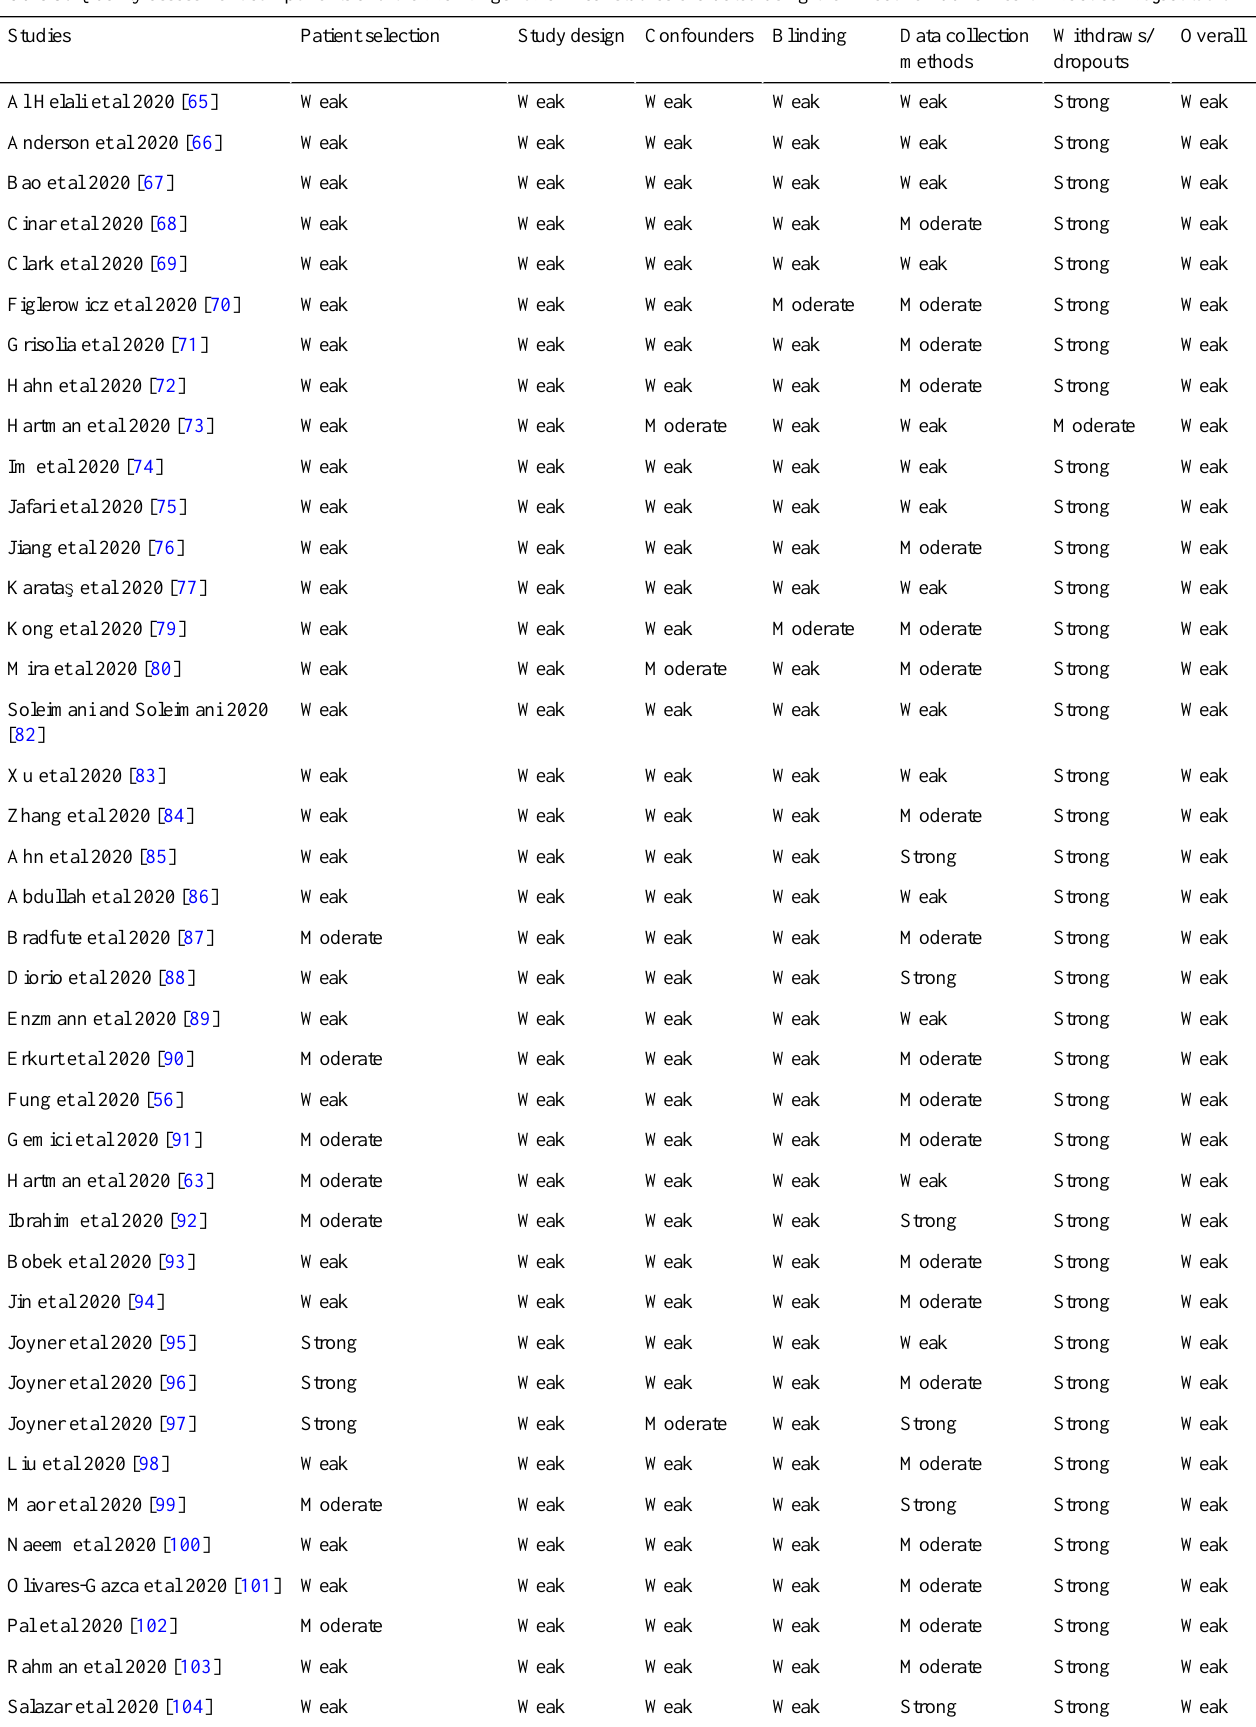
Table 3. Quality assessment components and their rankings for clinical studies evaluated using the Effective Public Health Practice Project